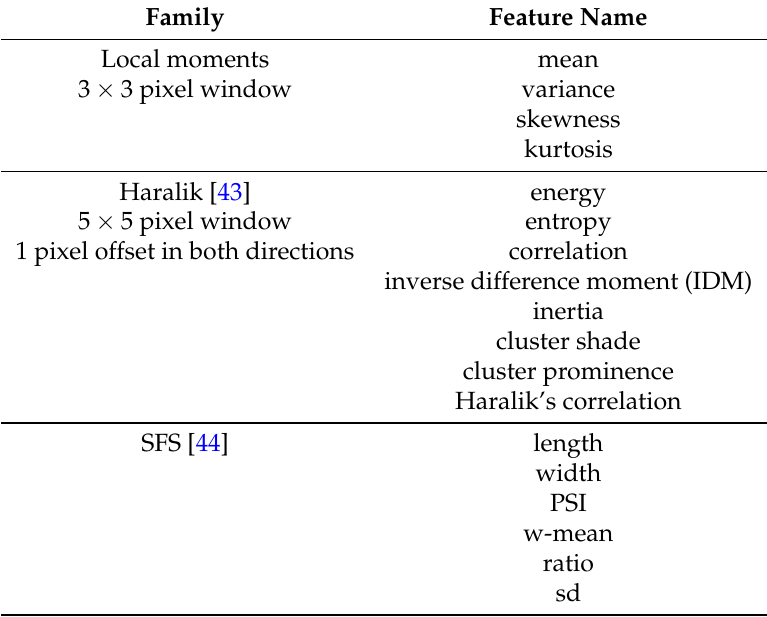
Table 5. SAR textures computed for every date in the time